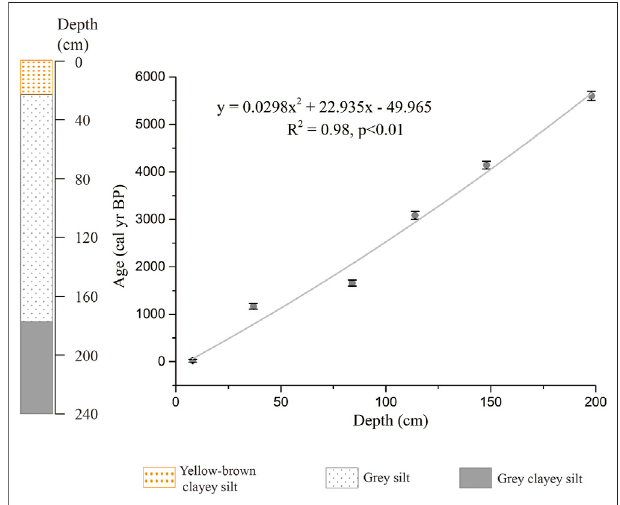
FIGURE 2 | Simpli fi ed lithological units and pro fi les of AMS 14 C age for sediment core GH6 (after Kong et al., 2021).